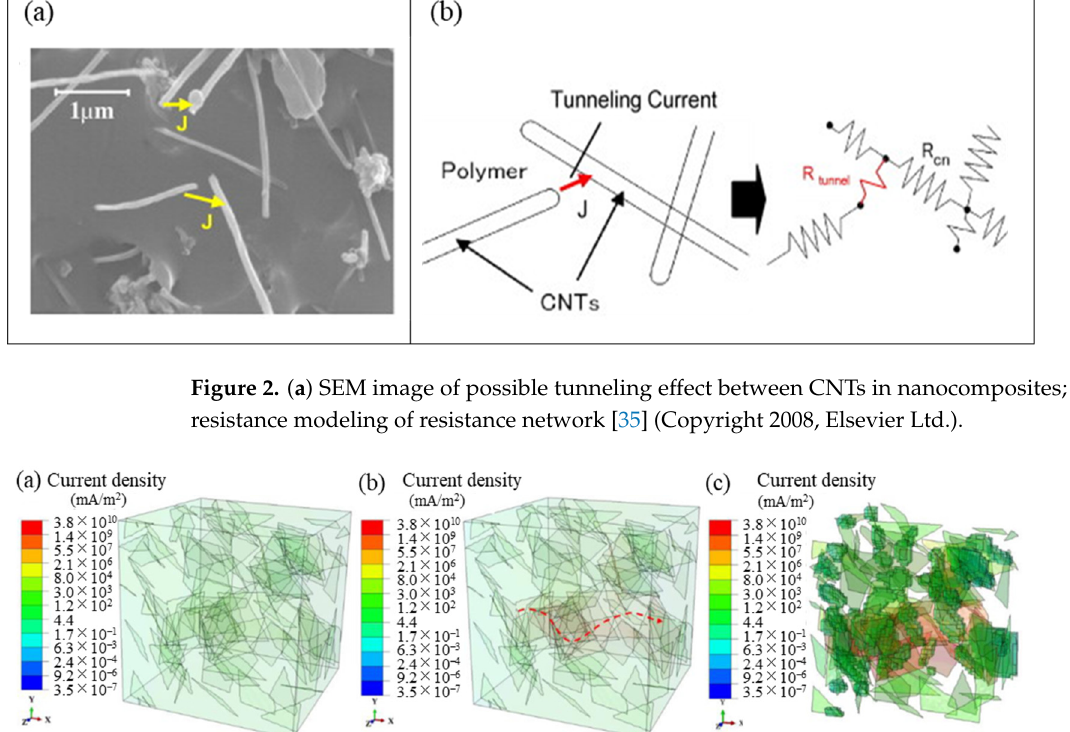
Figure 3. Current density distribution of graphene rubber composite: ( a ) ignoring tunnel effect; ( b ) considering tunnel effect; ( c ) conductive paths formed in graphene rubber composites [37] (Copyright 2020, Elsevier Ltd.).